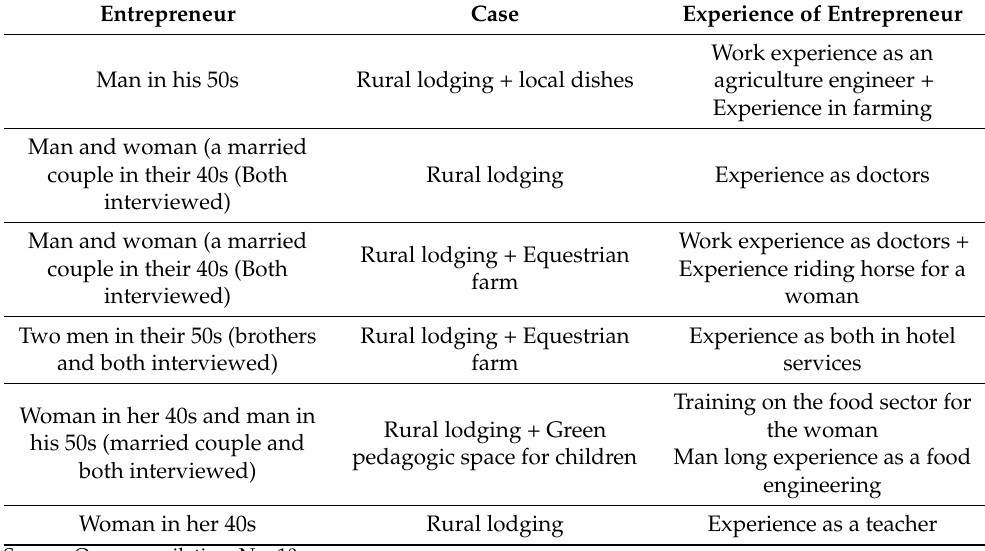
Table 2. Characteristics of the qualitative